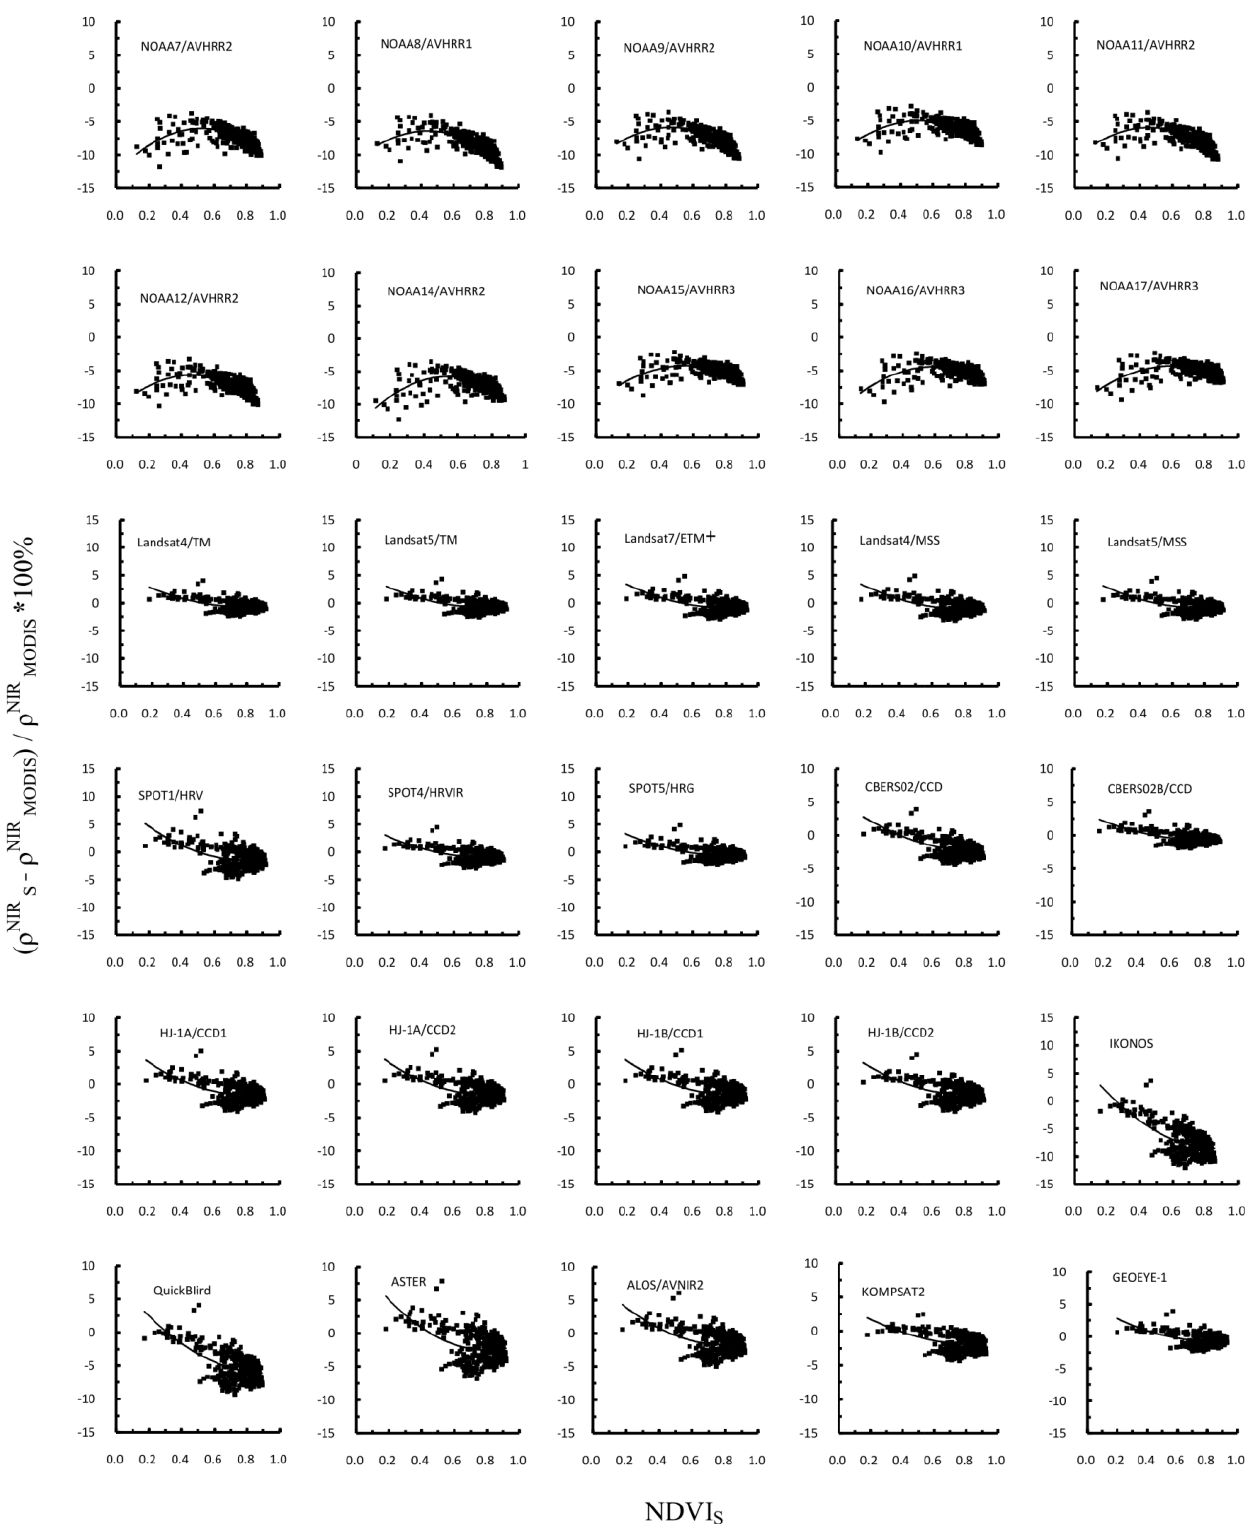
Figure 6. Relative percentage differences in the NIR channel reflectances with respect to Terra MODIS. All data points are plotted versus the NDVI of a particular sensor. Parameters for the fitting curves are given in Table